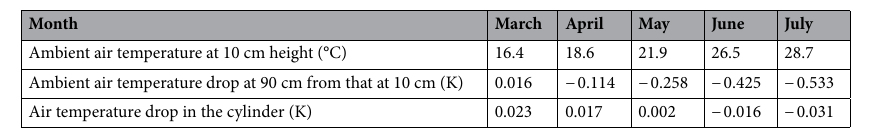
Table 3. The effect of the ambient air temperature on the temperature drop of the air column in a 22 cm diameter cylinder at 90 cm height position compared to the temperature at 10 cm height